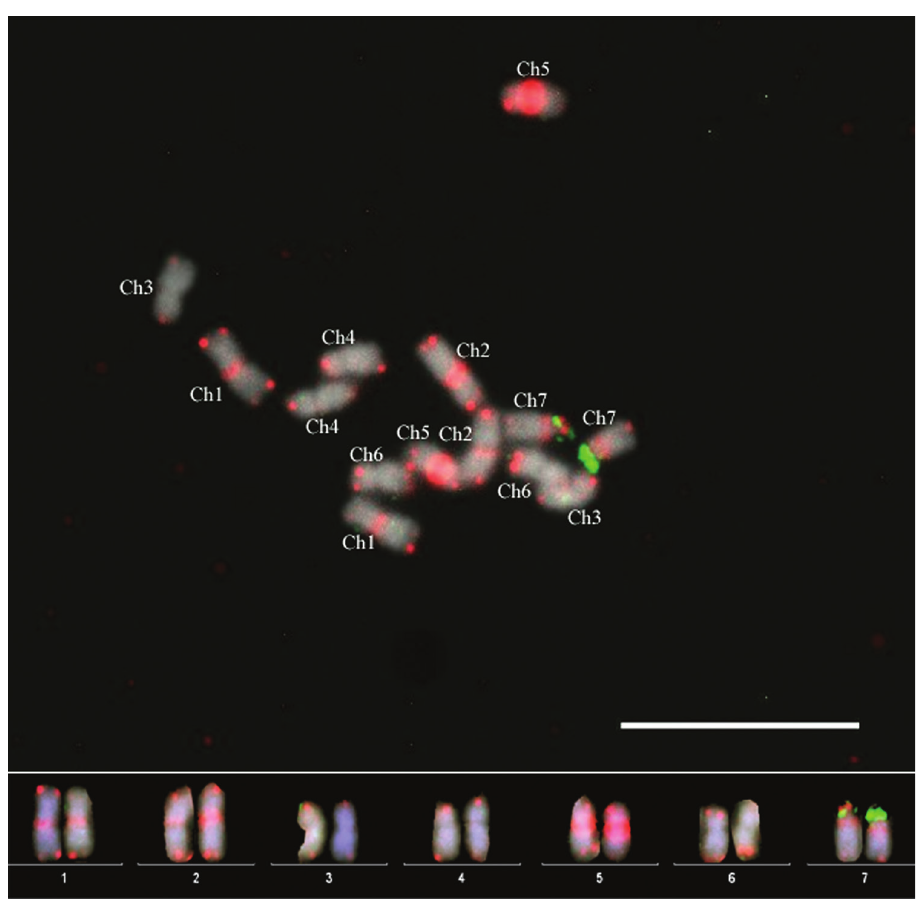
Figure 2. Double-color FISH under the low hybridization conditions using the Arabidopsis -type telomere repeat-based (red) and 45S rDNA (green) probes to R. wichurana mitotic chromosomes. Scales bar: 10